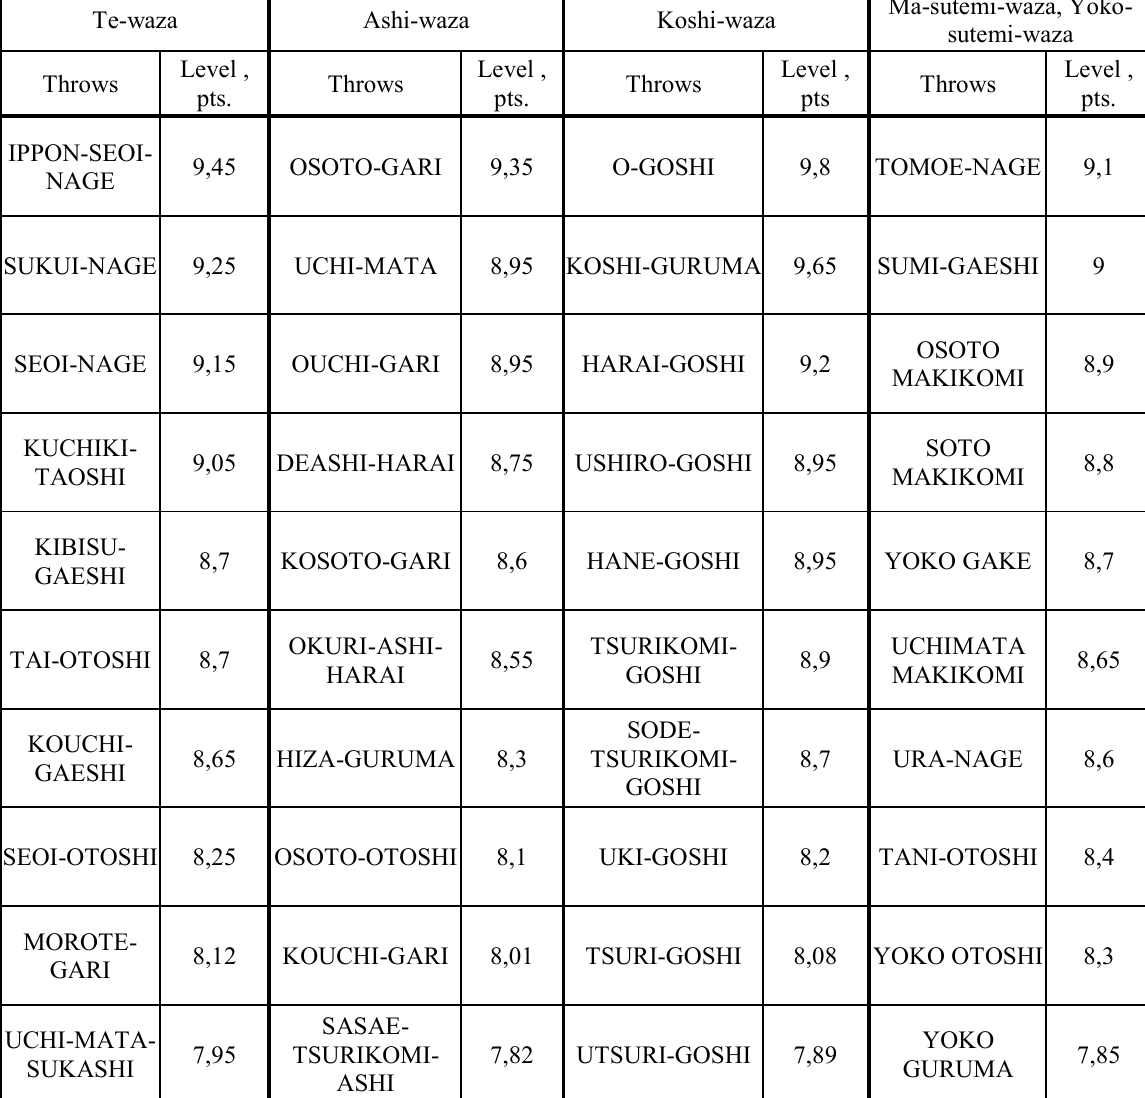
Basic technical skills (throws) in 17-19-year-old judokas and the level of their performance (points). Te-waza Ashi-waza Level , Level , Level , Level , Throws Throws Throws pts. pts